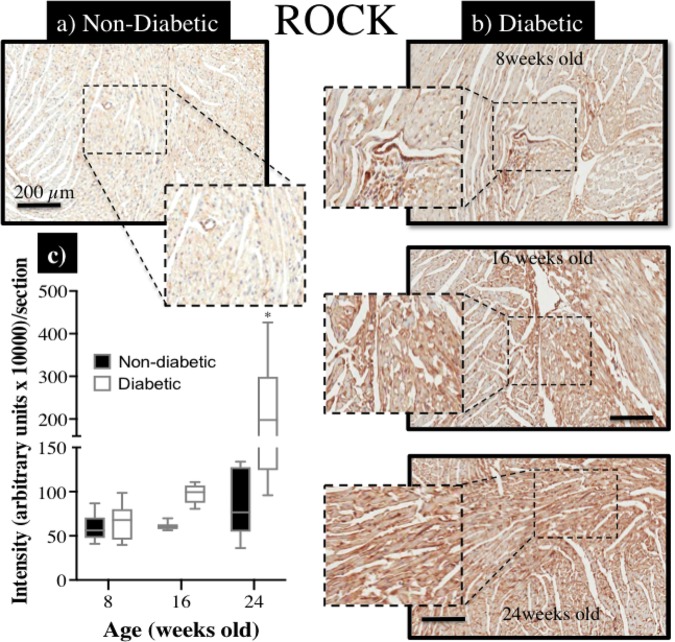
Immunohistochemical assessment of Rho-kinase protein (ROCK1) expression within myocardial sections retrieved from db/db (a) non-diabetic mice and, (b) diabetic mice at 8, 16, and 24 weeks of age; (c) the intensity of ROCK staining (brown precipitate) appeared to be progressively enhanced with age in diabetic hearts, compared to non-diabetic hearts, and significantly more so by 24 weeks of age (∗P < 0.05).